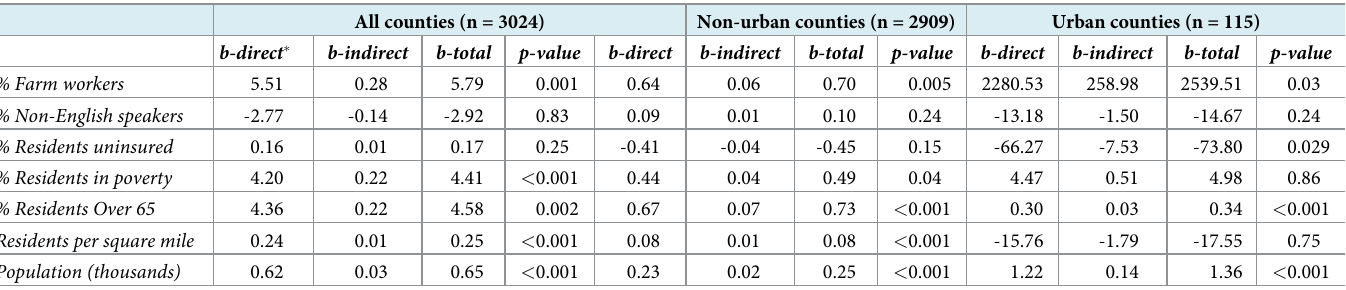
Table 2. Full spatial regression models: Absolute number of deaths associated with each covariate for all counties and stratified by urban/rural. All counties (n =